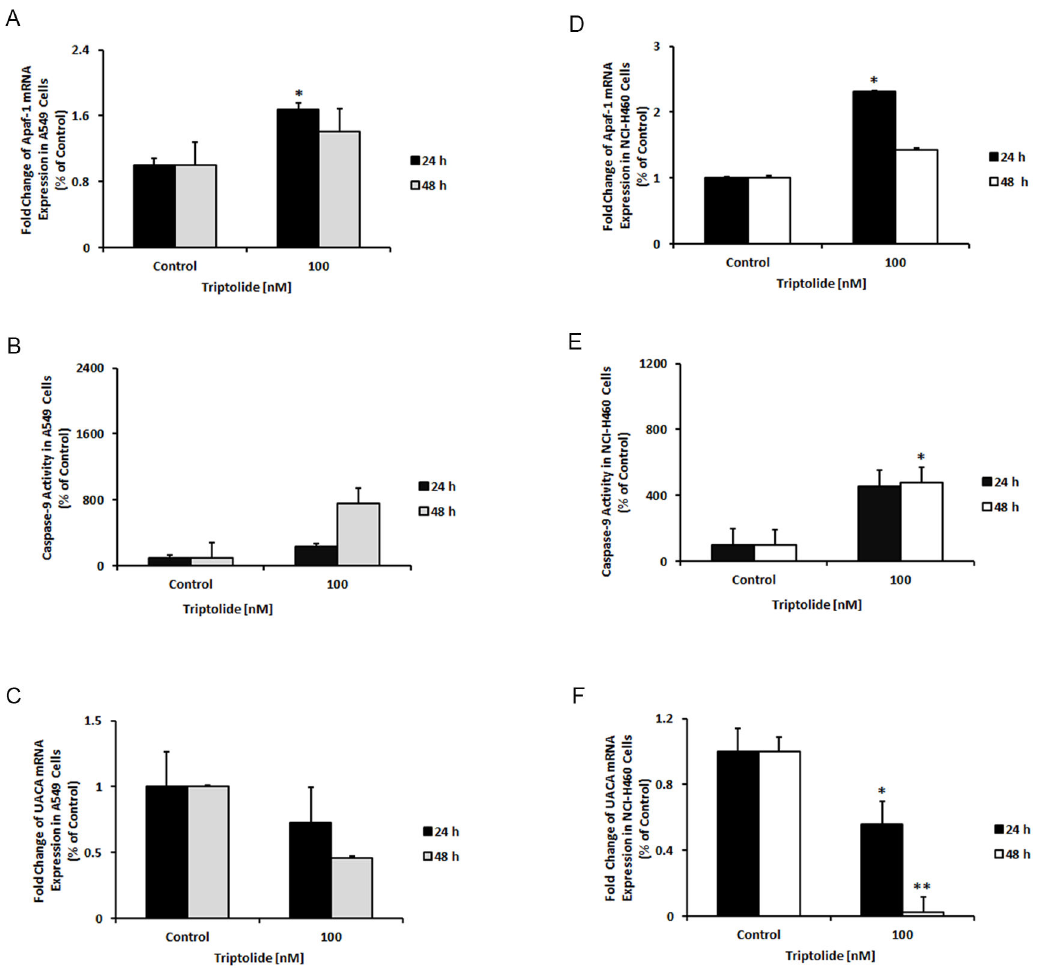
Figure 6. Triptolide promotes pro-apoptotic condition in A549 and NCI-H460 cells. Triptolide treatment increased Apaf-1 mRNA expression level in both NSCLC cell lines (A and D). In parallel, caspase-9 activity was increased in both NSCLC cell lines (B and E). Level of UACA mRNA expression was decreased after triptolide treatment (C and F). Columns , mean, bars , SE. Statistical significance of results was calculated with the Student`s t test (N=3) * P = 0.05; ** P =